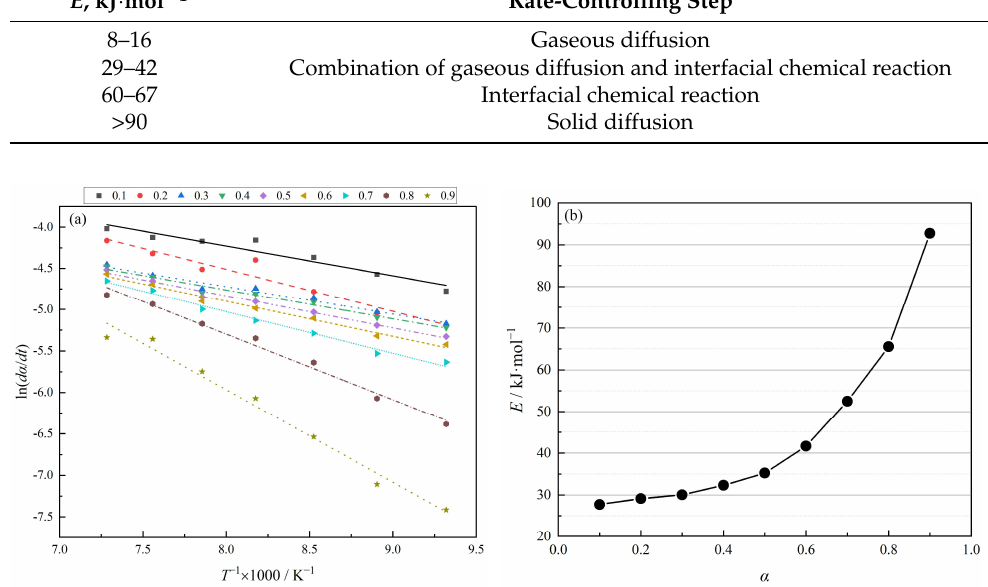
Figure 7. ( a ) Ln ( d α / dt ) against 1/ T of sample, and ( b ) activation energy with the increasing of reduction degree.